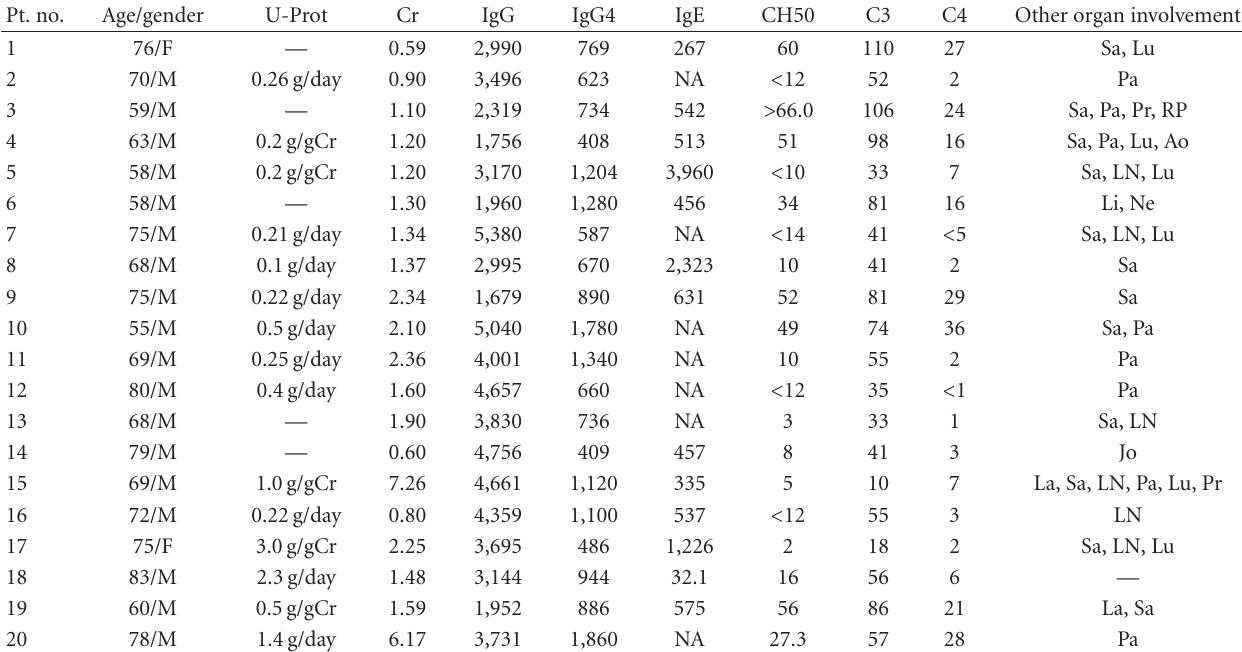
Table 1: Clinical and laboratory features of IgG4-related tubulointerstitial